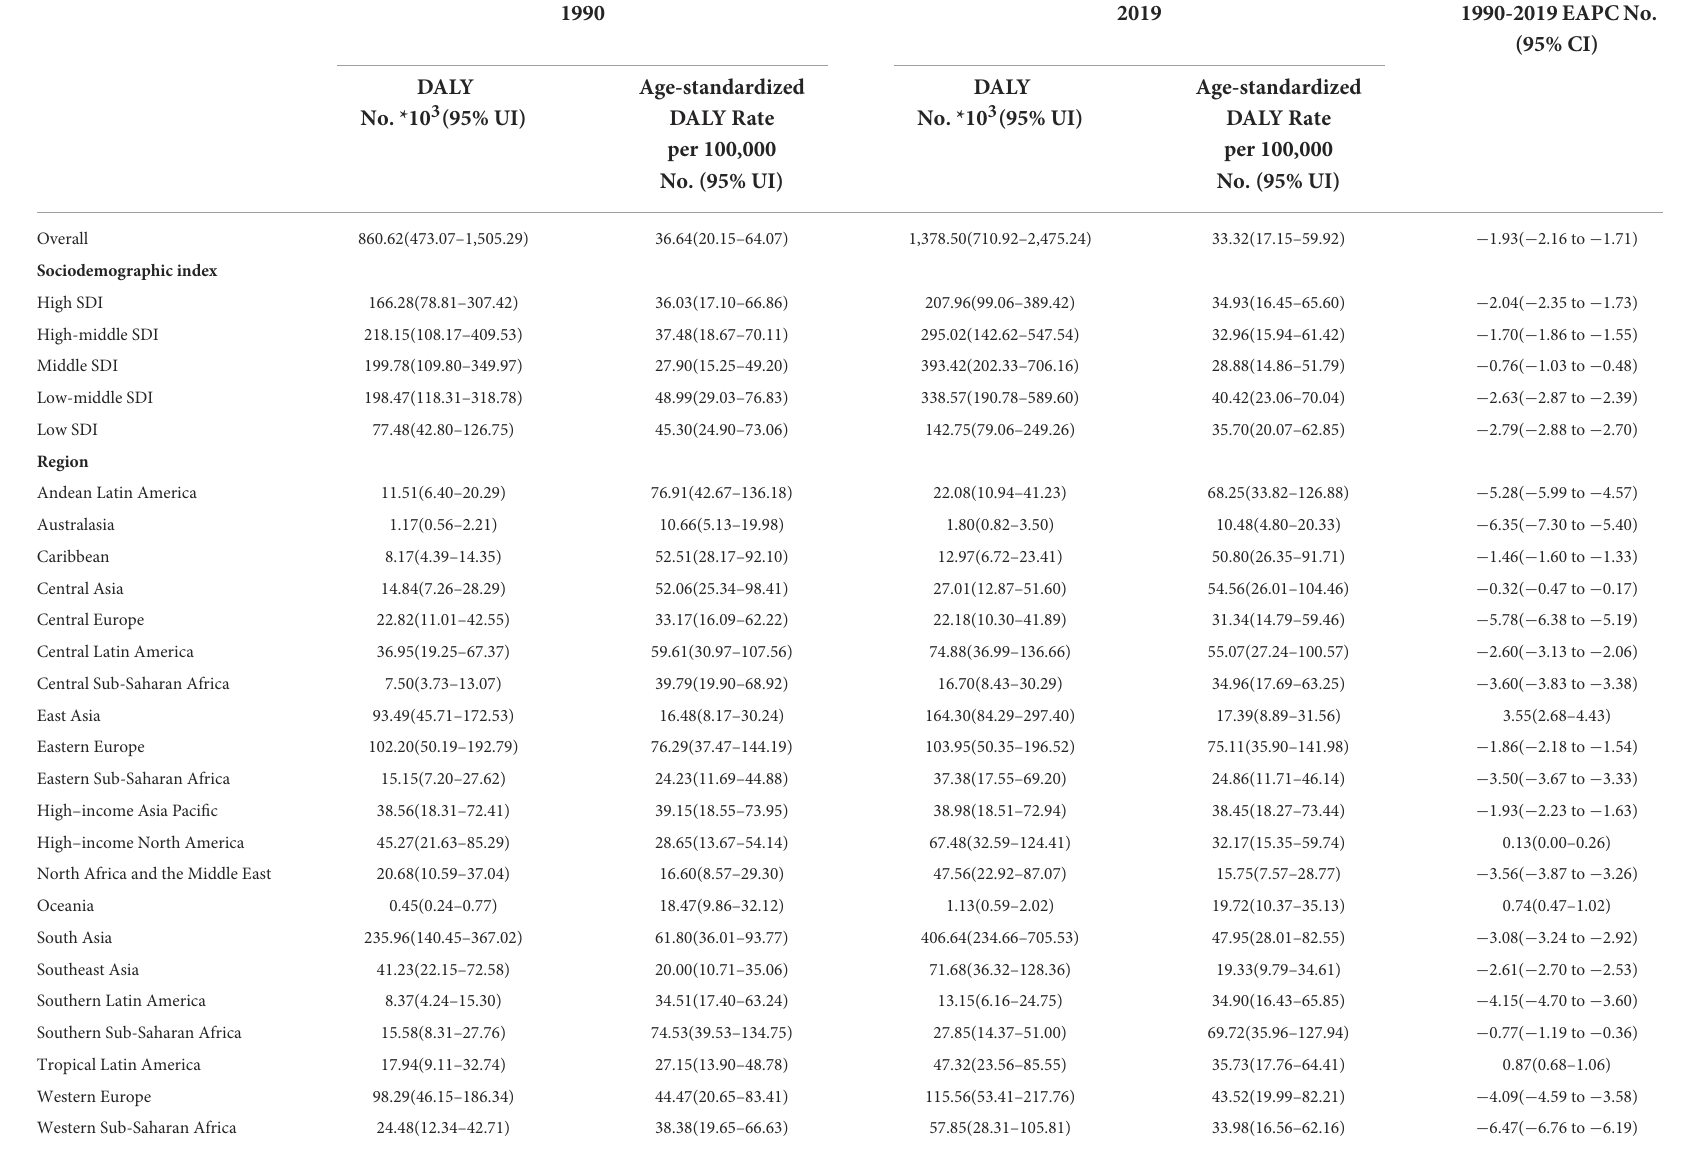
TABLE 3 The DALYs and age-standardized DALY rate from 1990 and 2019 and its temporal